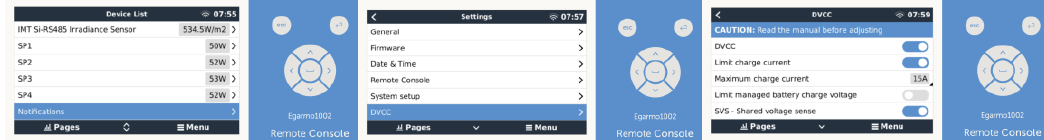
Figure 12. Synchronized operation of solar chargers using the DVCC function.